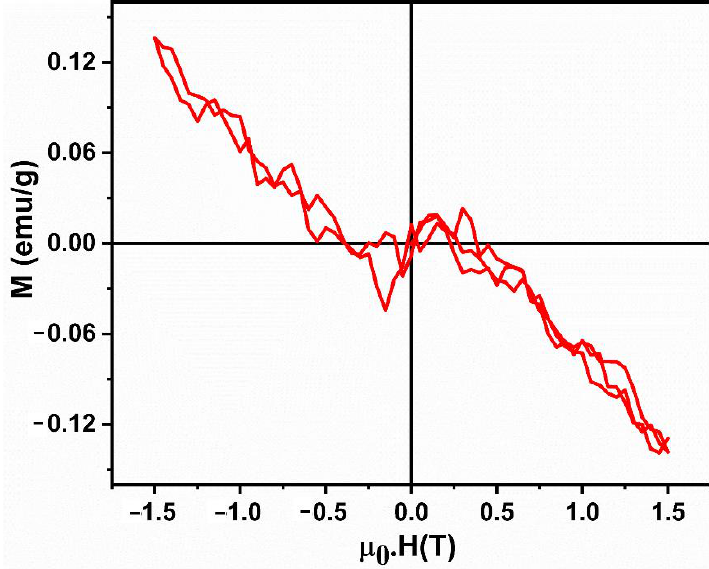
Figure 8. M-H hysteresis loop observed at room temperature. Table 1. Calculated value of susceptibility (χ), remanence (M r ), and magnetic coercivity (H ci ).